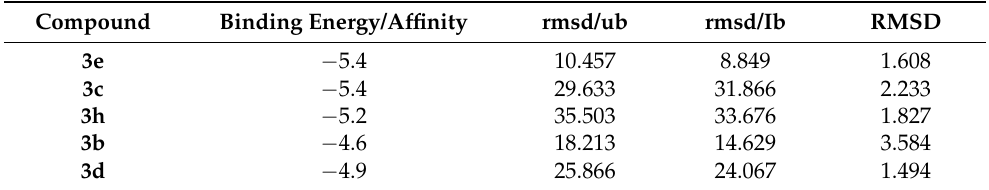
Table 5. Docking score of 6-bromo-4-phenoxyquinoline with the E. coli curli fiber biogenesis biofilm receptor protein (PDB ID: